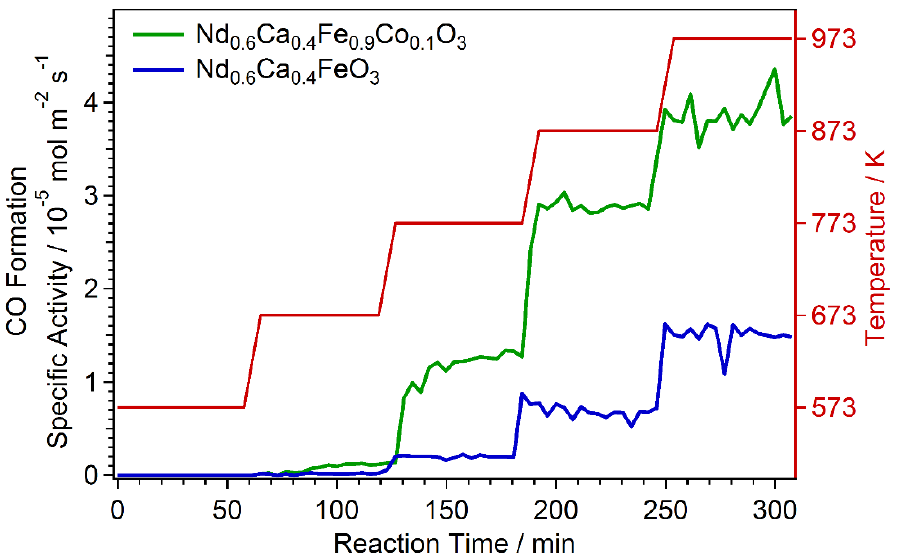
Figure 6. rWGS activity of undoped and Co doped catalyst. The temperature was stepwise increased with reaction onset above 573 K. For better comparability, the CO formation is given as specific activity (normalized by active catalyst surface area). Co nanoparticle exsolution from Nd 0.6 Ca 0.4 Fe 0.9 Co 0.1 O 3- δ improved the catalytic activity significantly.